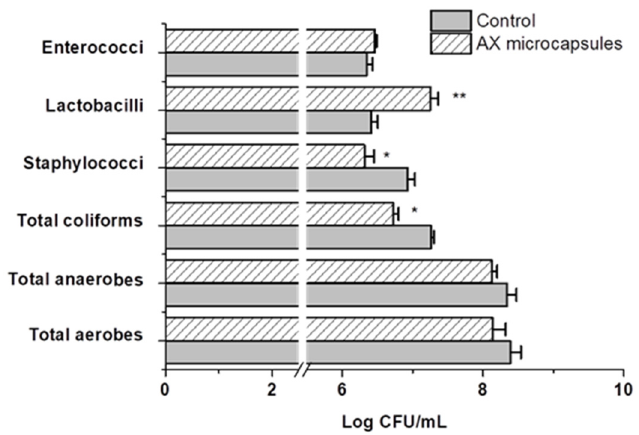
Figure 4. Average ( ± SEM) plate count measurements, expressed in log CFU mL − 1 , for different microbial groups untreated (control) and with treatment with AX gels microcapsules. Significant increases compared to the control are indicated by **, while significant decreases are indicated by * ( p < 0.05) ( n ≥ 4 per group).